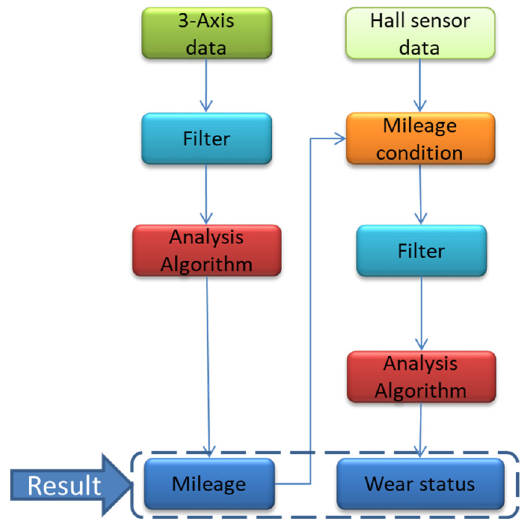
Figure 3. Process